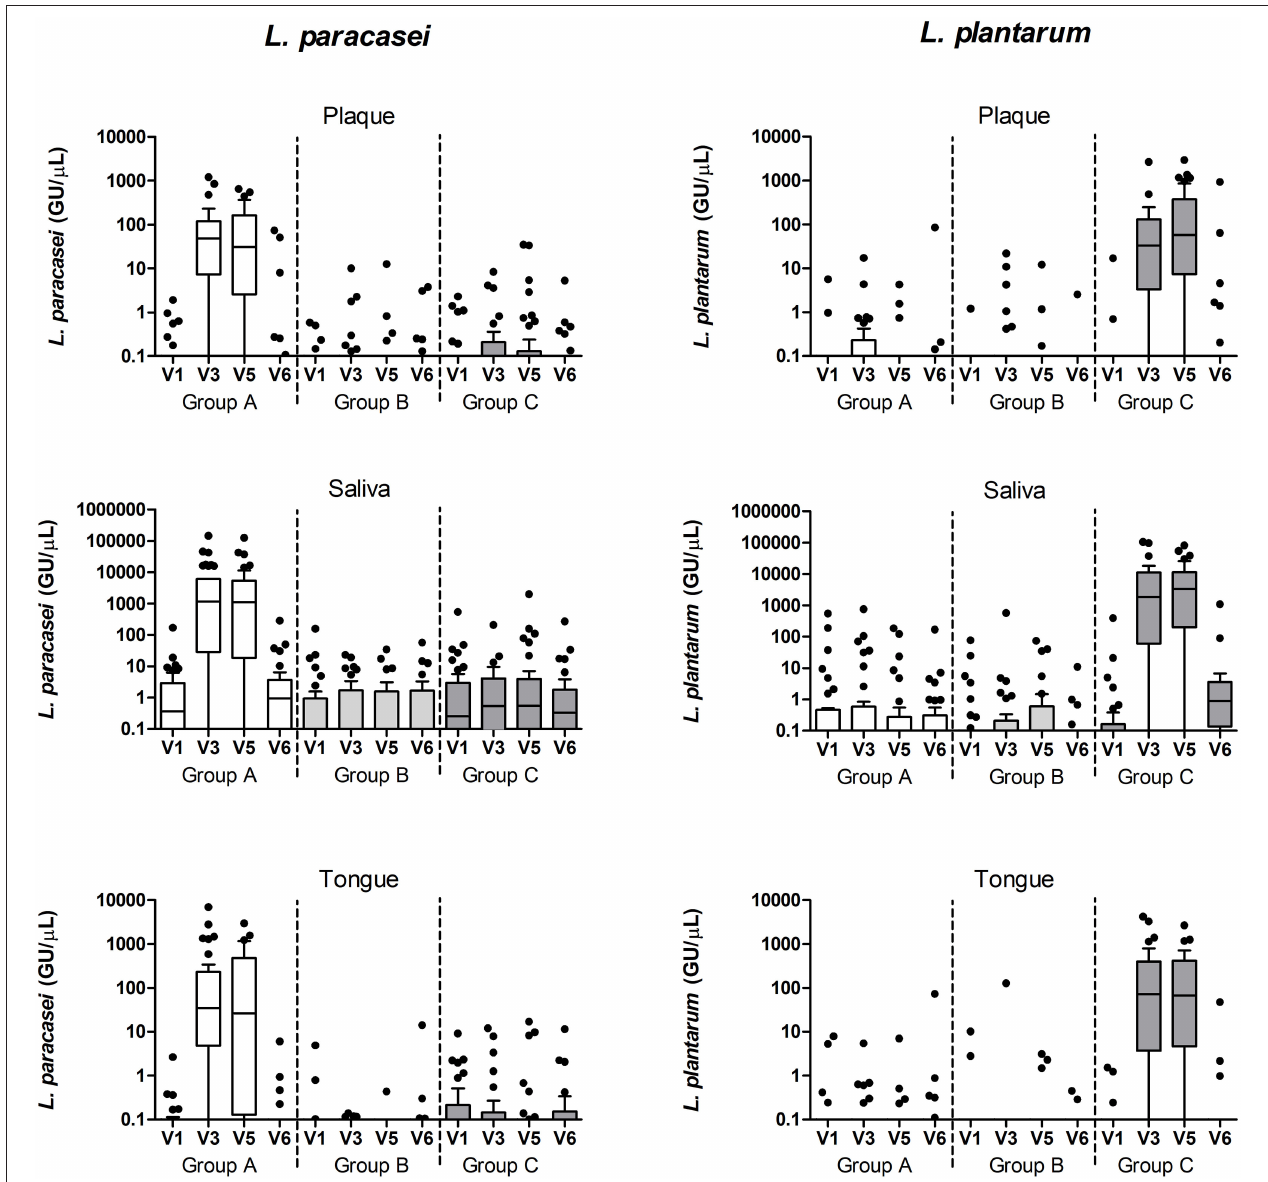
FIGURE 7 | L. paracasei and L. plantarum qPCR counts (genomic units/ µ L sample) in plaque, saliva, and tongue samples per study group and visit.